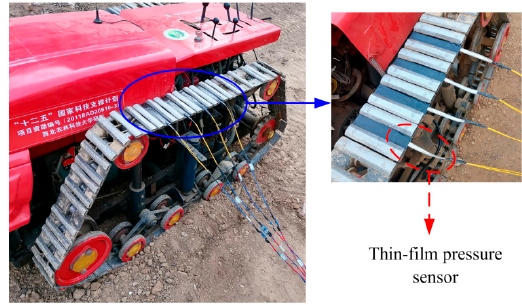
Figure 18. Distribution of pressure sensors.